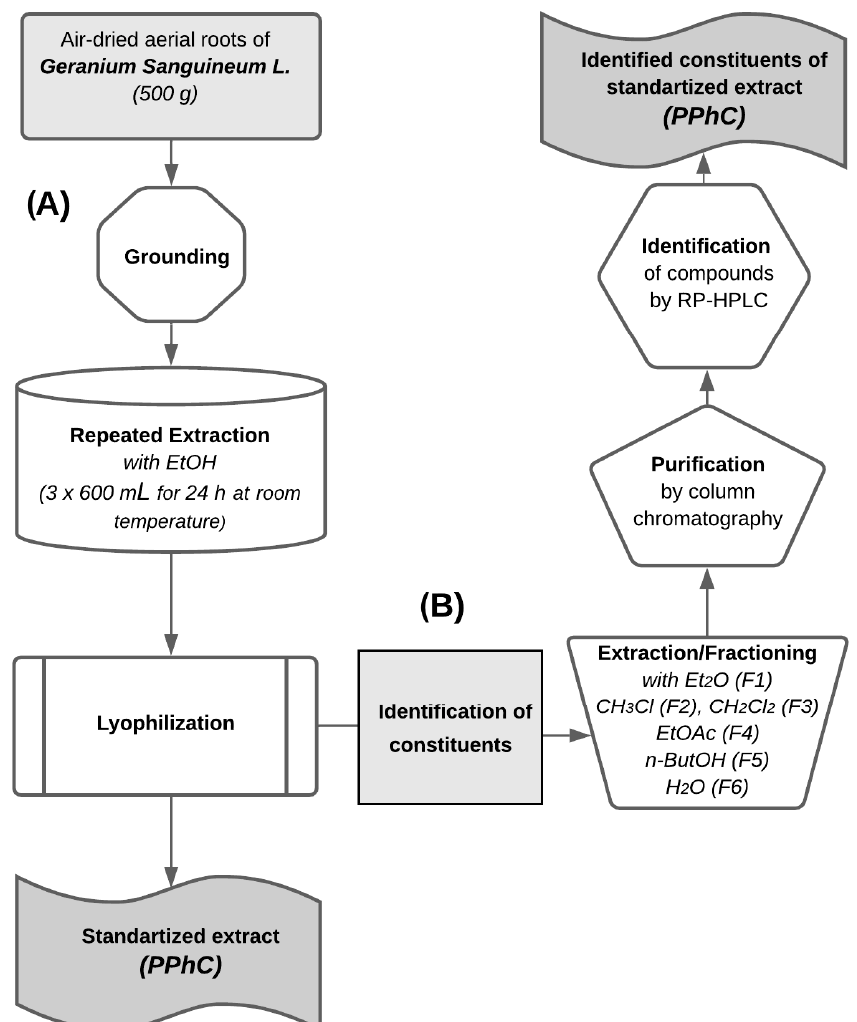
Figure 1. Flow chart for isolation and analysis of standardized extract of Geranium sanguineum L. ( A ) Isolation procedure of standardized ethanol extract of Geranium sanguineum L. ( B ) Analytical procedure for the identification of the individual compounds of standardized extract of Geranium sanguineum